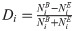
Analysis of protein complexes.(A), To compare the structural determinants of bacteria-eukaryote (BE) complexes, 89 nonredundant complexes were obtained from the PDB and compared to 183 bacteria-bacteria (BB) and 686 eukaryote-eukaryote (EE) complexes. (B) Hierarchical clustering and (C), principal component analysis of amino acid composition in BE, BB and EE protein complexes. All percentages were controlled by the amino acid structure of the protein. (D) To characterize the interaction pattern in BE complexes, the number of interactions for each amino acid in BE complexes was plotted against EE and BB complexes. Regression lines were calculated using the Spearman rank-correlation approach to control for the impact of extreme values. (E) Hierarchical clustering of the interaction pattern for each amino acid. The correlation coefficient for each amino acid was calculated comparing the number of interactions with all other amino acids in BE complexes against EE and BB complexes. (F) Distribution of Pearson correlation coefficients as calculated in panel E for BE complexes against EE and BB complexes. The inner panel shows the p-value distribution in a resampling control to correct for effect size (see Materials and Methods) (G) Directionality for each amino acid (Di) in BE interactions was calculated as the relative difference in the number of interactions (N) in both directions Di=NiB−NiENiB+NiE. (H) Distribution of the angle measured for all anion-pi interactions involving Trp in BE complexes.